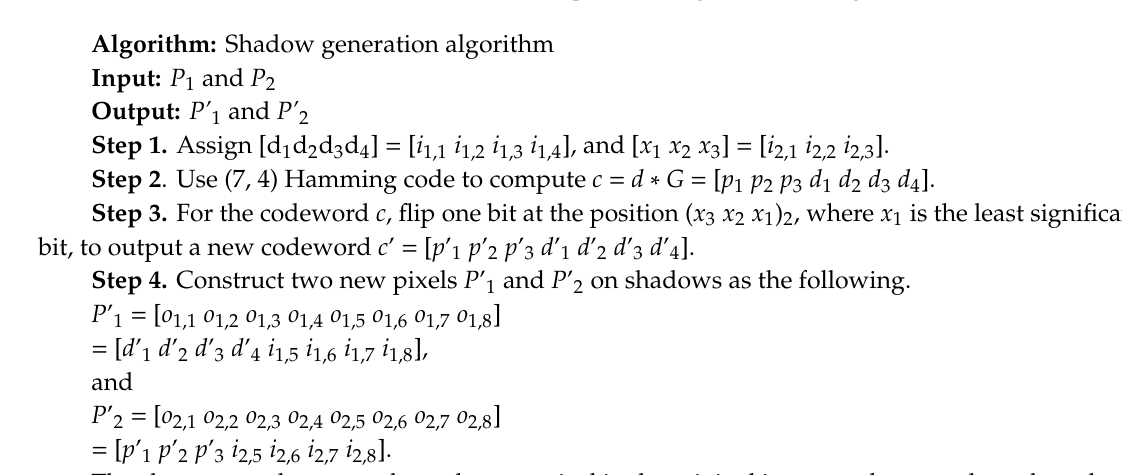
Figure 1. Shadow construction process using (7,4) Hamming code.